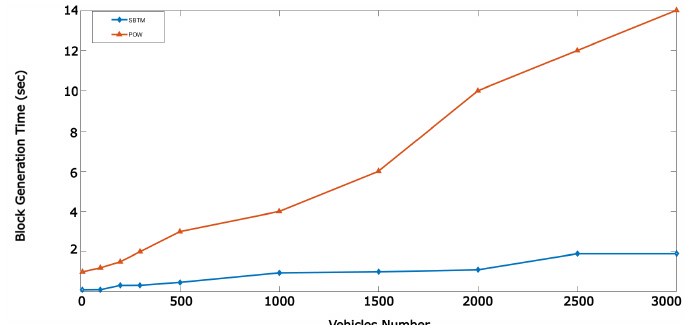
Figure 13. Comparison generation block time between Sharding and POW.